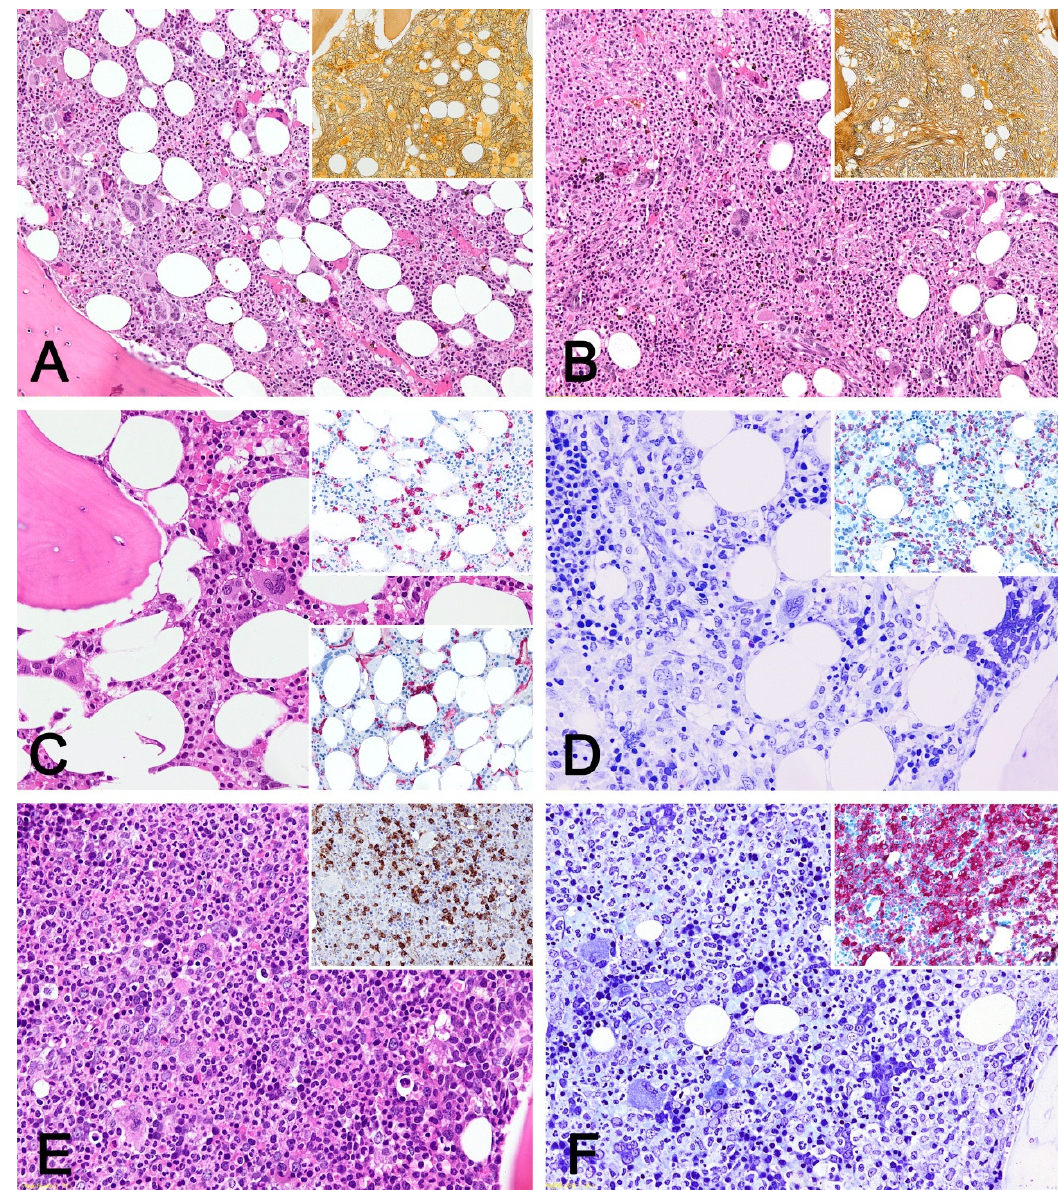
Figure 1. ( A ) Post-ET MF: hypercellular marrow with prominent granulopoiesis and expanded megakaryocytes; some of the latter look more ET-like than PMF-like; H&E ×10; inset: grade 2 fibrosis; Gomori silver impregnation ×10.( B ) Post-PV- MF: hypercellular marrow with prominent granulopoiesis and expanded megakaryocytes; most of the latter show MF- like morphology although variability occurs; H&E ×10; inset: grade 3 fibrosis; Gomori silver impregnation ×10. ( C ) ET in accelerated phase: histology shows features of typical ET with mild increase in precursors; H&E, ×10; inset: the CD34 staining highlights increases in positive blastic cells that overall account for more than 10% cellularity (12% on the whole biopsy) and also shows occasional clustering features; ×10. ( D ) PMF JAK2 -mutated case in blastic phase: myeloid matura- tion arrest and increase in blasts; residual erythroid precursors and few atypical megakaryocytes can be observed; H&E ×10; inset: CD34 positive blasts accounting for 35–40% cellularity; ×10. ( E ) JAK2 positive PMF case with subsequent devel- opment of monocytosis: hypercellular marrow with increase in granulopoietic precursors and monocytes with CMML- like features; H&E ×10; inset: increase in CD14 positive monocytes; ×10. ( F ) PV with late development of leukocytosis: expansion of granulopoietic cells and erythroid precursors; Giemsa ×10; inset: excess of myeloperoxidase positive granu- lopoetic cells with preserved maturation; ×10.